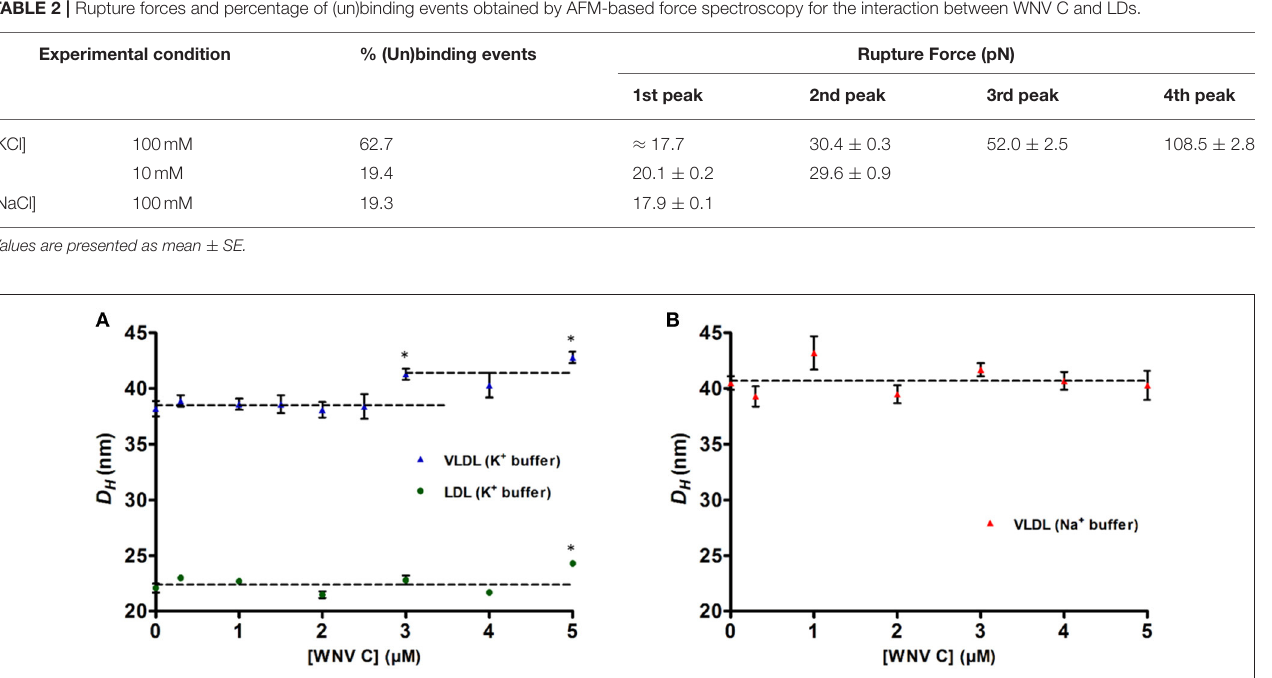
FIGURE 3 | DLS analysis of lipoproteins hydrodynamic diameters upon titration with WNV C. In TEE buffer with 100mM KCl, VLDL (blue triangles) average hydrodynamic diameter ( D H ) increases 4.5 ± 0.6nm in the presence of WNV C, but no significant variation is observed for LDL (green circles) (A) . In TEE buffer with 100mM NaCl, the D H of VLDL (red triangles) does not change significantly upon increasing WNV C concentration (B) . K + is therefore crucial for WNV C-VLDL interaction. D H values (presented as mean ± SE) are the average of three independent measurements for each point (* p < 0.005). Dashed lines correspond to the average of each set of results.